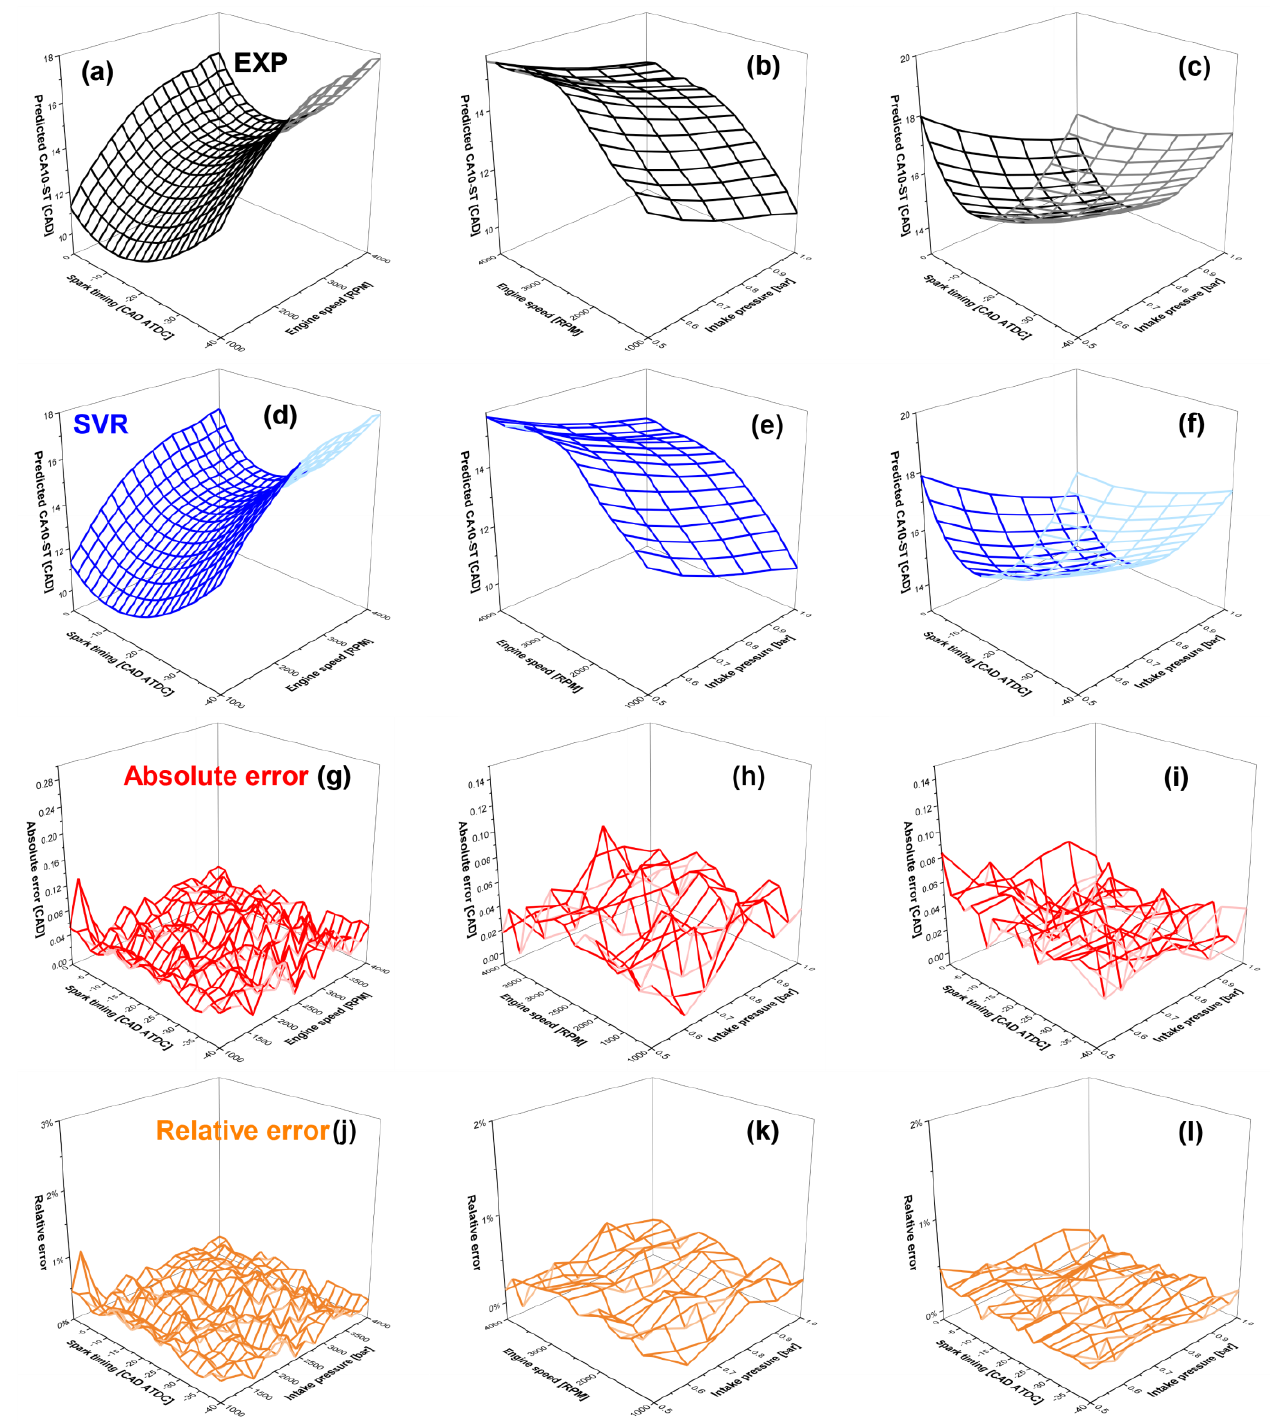
Figure 14. CA10 − ST versus different operation parameters combination. ( a , d , g , j ) Prediction perfor- mance when spark timing and engine speed change (intake pressure = 1 bar); ( b , e , h , k ) prediction performance when engine speed and intake pressure change (spark timing = − 20 CAD ATDC); and ( c , f , i , l ) prediction performance when spark timing and intake pressure change (engine speed = 2600 RPM).